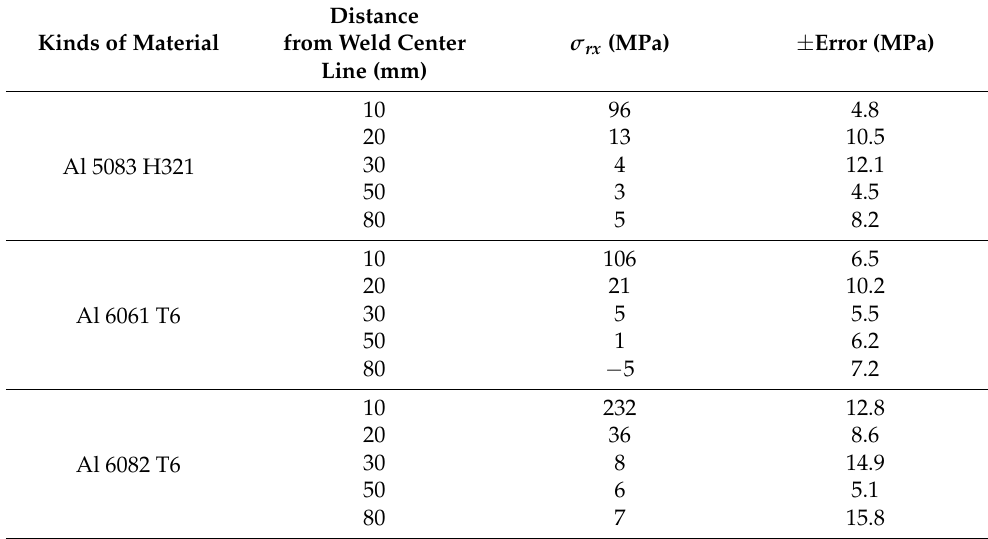
Table 11. Measured data of welding-induced residual stresses.